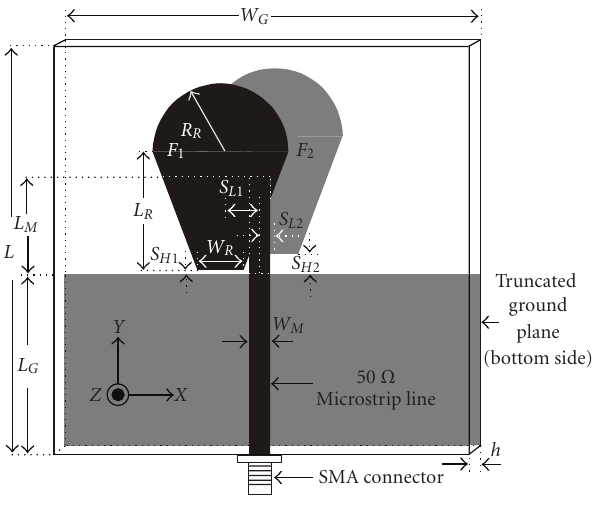
Figure 1: Geometry and optimized dimensions of the proposed an- tenna [ L = 67, W G = 67, L G = 29, L M = 15, W M = 3, W R = 7 . 5, R S . 3, S . 5, S S . 25, h = 1 . 6 L R = 19, R = 11, H 1 = 0 L 1 = 6 H 2 = 3, L 2 = 5 (units in mm), ε r = 4 . 4].